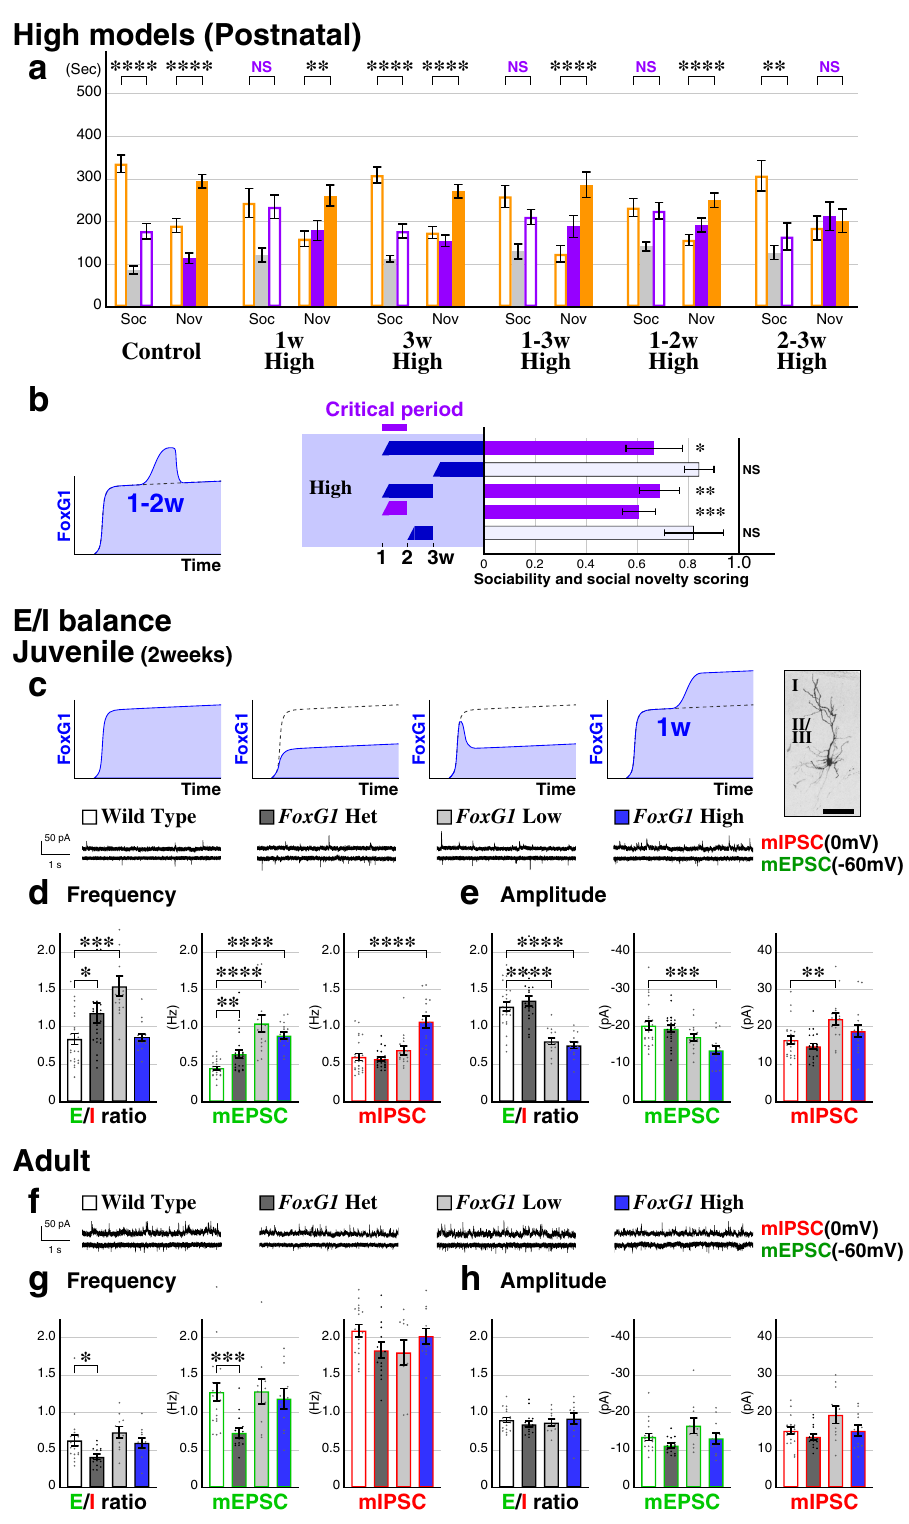
rescue of E/I balance at 2 weeks in Heterozygotes upon into wild type animals did not overtly affect the sociability of the GABAergic cell precursor transplantation restores the E/I balance animals at 6 weeks and was comparable to non-transplanted wild to normalcy in adulthood (Fig. 6e, f). type (Fig. 1b) or other control animals (Figs. 2m and 3b). When We next tested if correcting the E/I balance of the mPFC at two FoxG1 Heterozygotes received GABAergic cell precursors into the weeks would rescue the adult ASD-like social behavioral mPFC at postnatal 1 week (Fig. 6a and h), the animals spent impairments of the Heterozygous animals. In the three- comparable time in the social side of the chamber to the controls chamber assay (Fig. 6g and j), GABAergic cell transplantation during the sociability session (Fig. 6j, NS in orange). During social NATURE COMMUNICATIONS| (2021) 12:3773